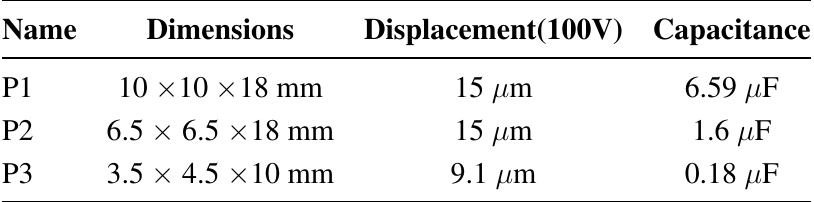
Table 1. Specification of PZT actuators P1, P2 and